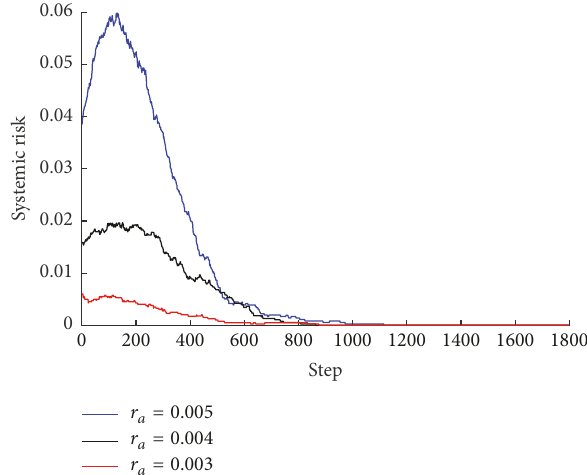
Figure 9: Systemic risk under different values of 𝛽 . The parameters are set as 𝑑 = 0.0533 , 𝛿 𝑎 V 𝑒 = 0.009 , 𝜃 = 0.04 , 𝑝 = 0.05 , 𝐶 = 0.03 , 𝜎 = 0.15 , 𝜎 = 0.25 , 𝐴 = 1000 , 𝑤 = 500 , 𝜒 = 0.3 , 𝐵𝑎𝑛𝑘𝑁𝑜 = 200 , 𝐴 𝑤 𝐴𝑠𝑠𝑒𝑡𝑁𝑜 = 150 , 𝑟 = 0.004 , and 𝑟 = 0.008 𝑎 𝑎